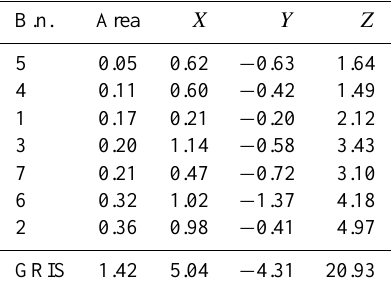
Table 2. Degree-1 sensitivity kernel for Greenland. The first column indicates the basin number (or region), the second its area, and the other 3 columns indicate the variation in Gt due to 1mm of variation in the geocenter coordinates X , Y and Z (Gtmm − 1 ).